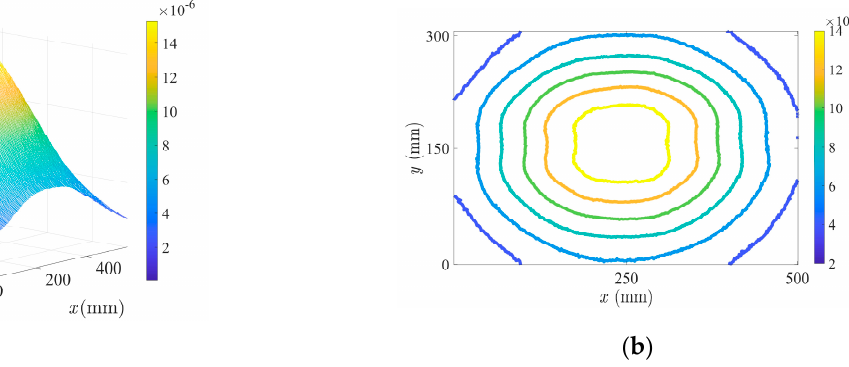
Figure 10. Extracted experimental α a × F h → m , n for each element of the sheet ( a ) surface graph; ( b ) numerical values of α a × F h → m , n in contour graph. Table 1. Thermal and physical properties for thermoplastic sheet. Direction Symbol Value Unit Thermal Conductivity K 0.18 ( W/m.K ) Specific Heat c p 1465 ( J/kg K ) Density Ρ 1380 (kg/m (cid:2871) ) Emissivity ε s 0.95